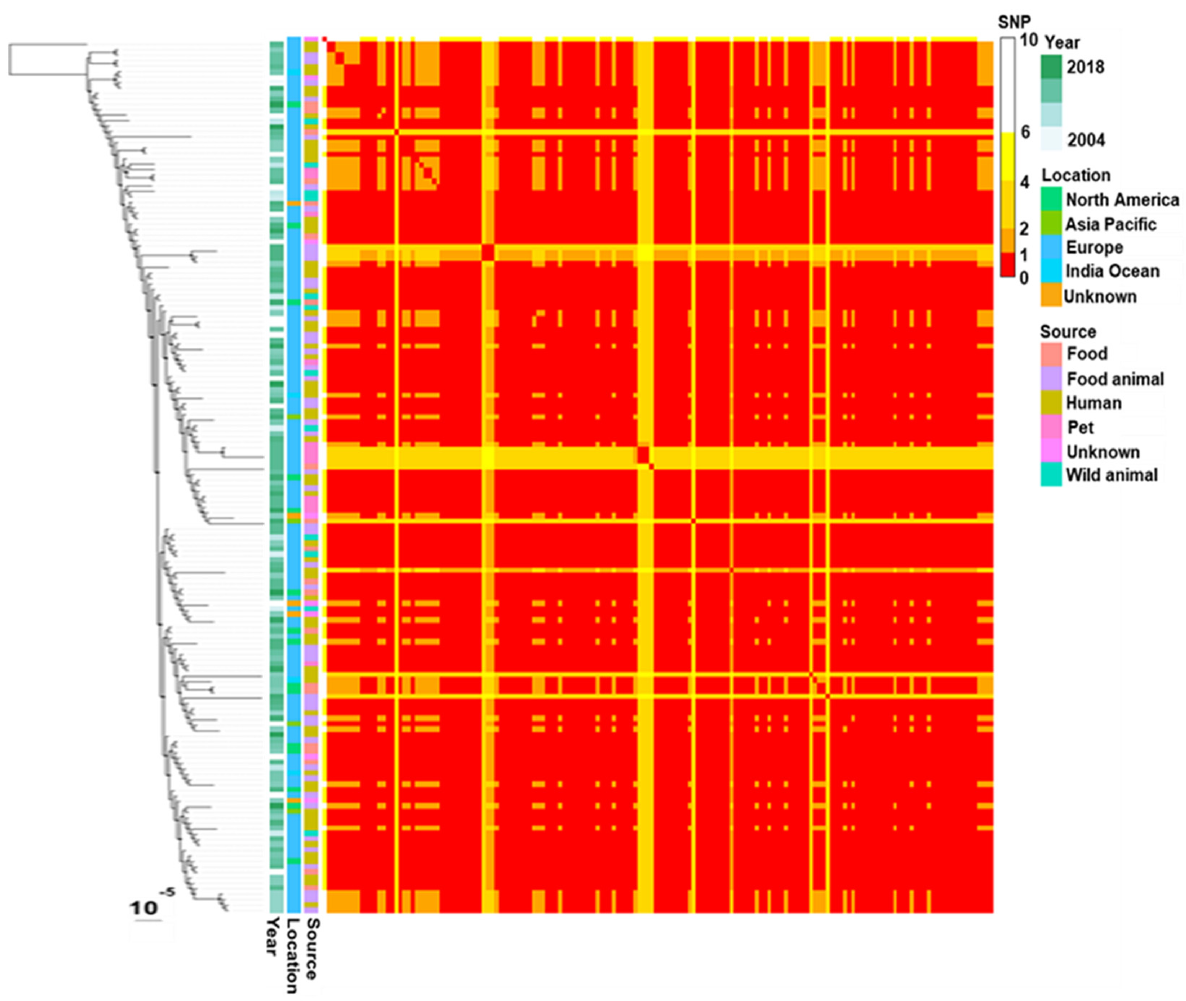
Figure 4. Phylogenetic tree and corresponding distance matrix based on SNPs of plasmids IncI1-ST3 encoding bla CTX-M-1 . SNP calling, SNP filtering and tree inferring were performed with bactSNP, Gubbins and RAxML, respectively.